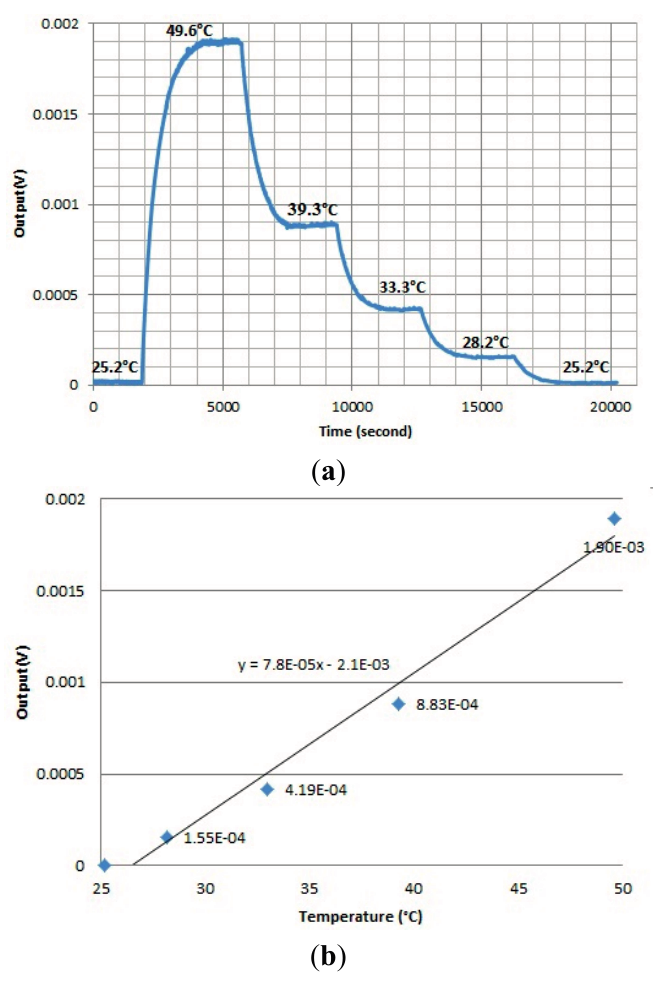
Figure 5. ( a ) Responses of the chip calorimeter towards Joule heating; ( b ) Output voltage vs. temperature